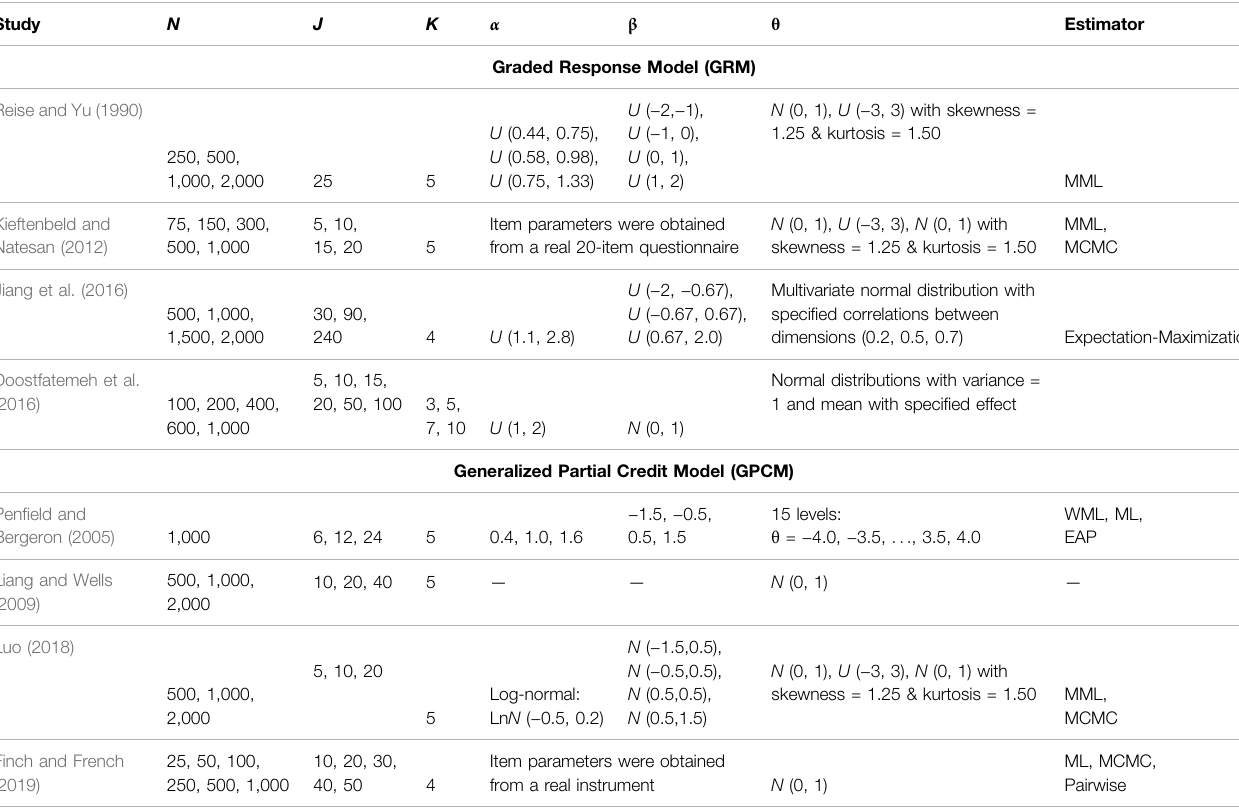
TABLE 1 | Previous Literature on the Performance of GRM and